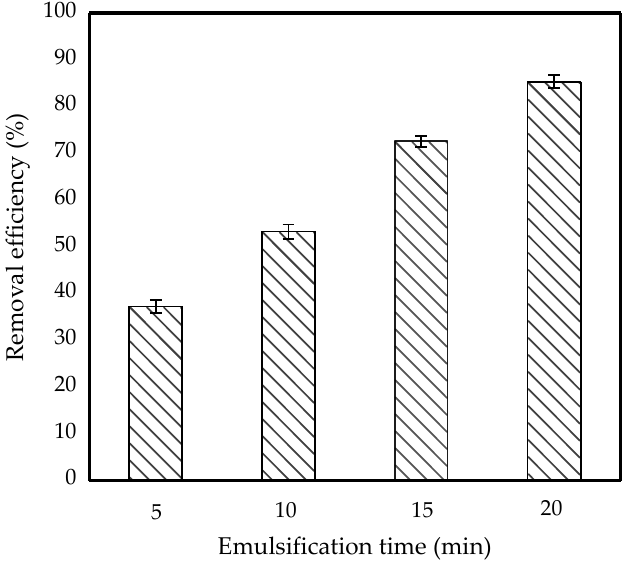
Figure 5. Effect of emulsification time on removal efficiency of 10 ppm IBP. (Condition: [TOA] = 6 wt%; [Span 80] = 6 wt%; Stirring speed = 300 rpm; O/I = 3:1; Kerosene = 30 mL).